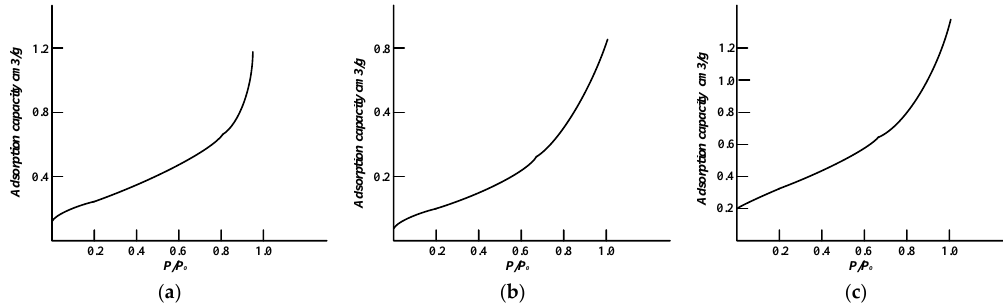
Figure 8. Low temperature nitrogen adsorption isotherm. ( a ) Qianjiaying; ( b ) Xiaonan; ( c ) Liujia.